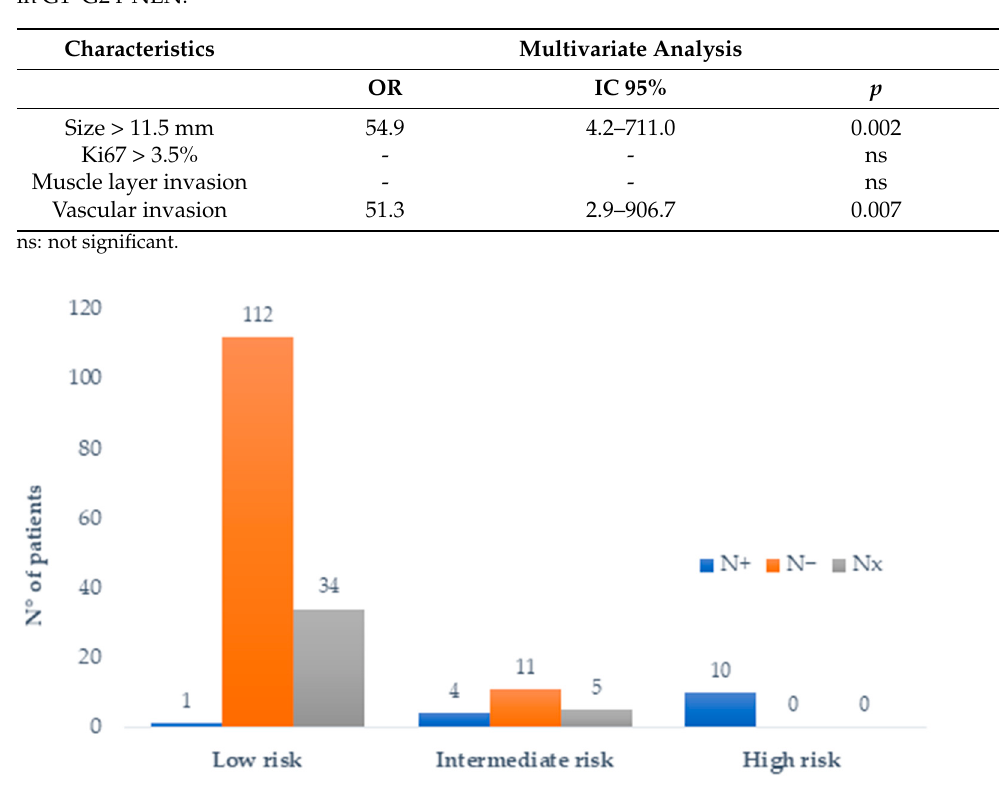
Table 2. Multivariate analysis of clinical and histopathological factors predicting nodal involvement